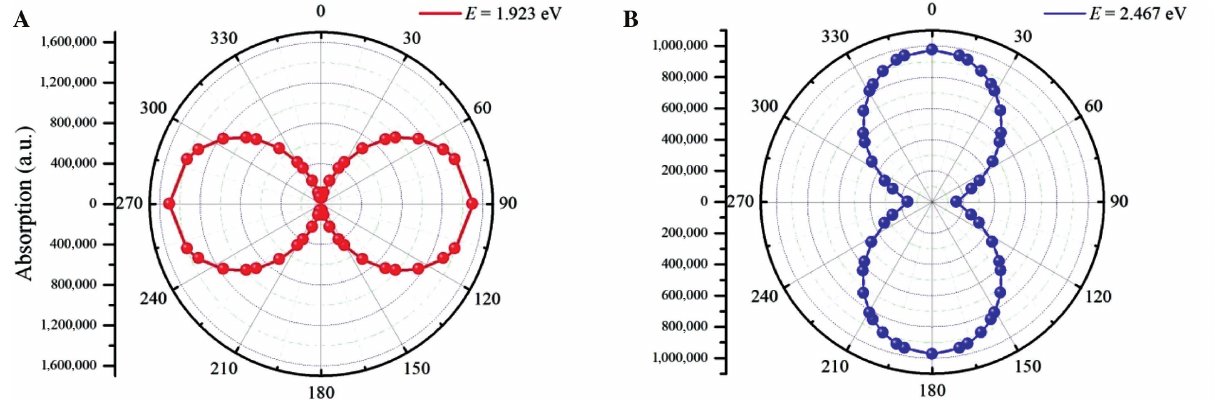
Figure 7: Anisotropy excitons in bilayer tellurene. The polarization dependence of excitons for the energies of (A) 1.923 and (B) 2.467 eV to mimic the absorption spectra of bilayer tellurene. The polarization angle θ is set to the light polarization with respect to the covalent bond